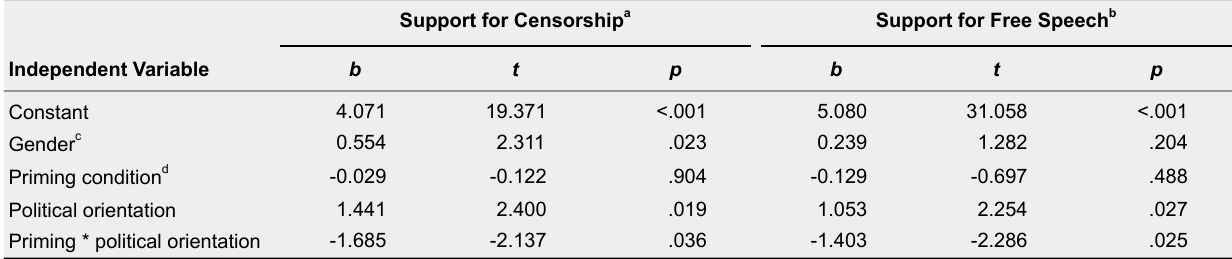
Regression Coefficients for a Multivariate Regression Model With Support for Censorship and Support for Free Speech as Dependent Variables, and Priming Condition, Political Orientation (Mean Centered), Gender, and Experimental Prime by Political Orientation Interaction as